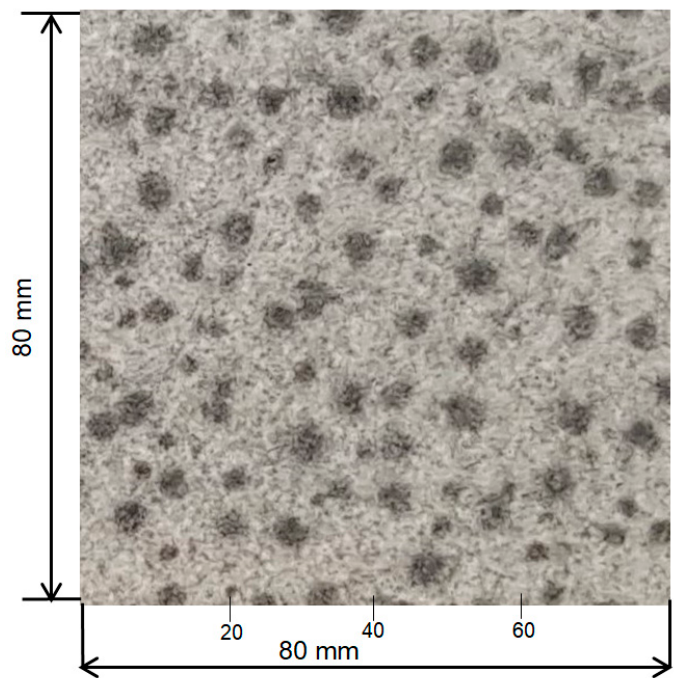
Figure 13. Mica paper sample with non-uniform elastic properties and thickness.